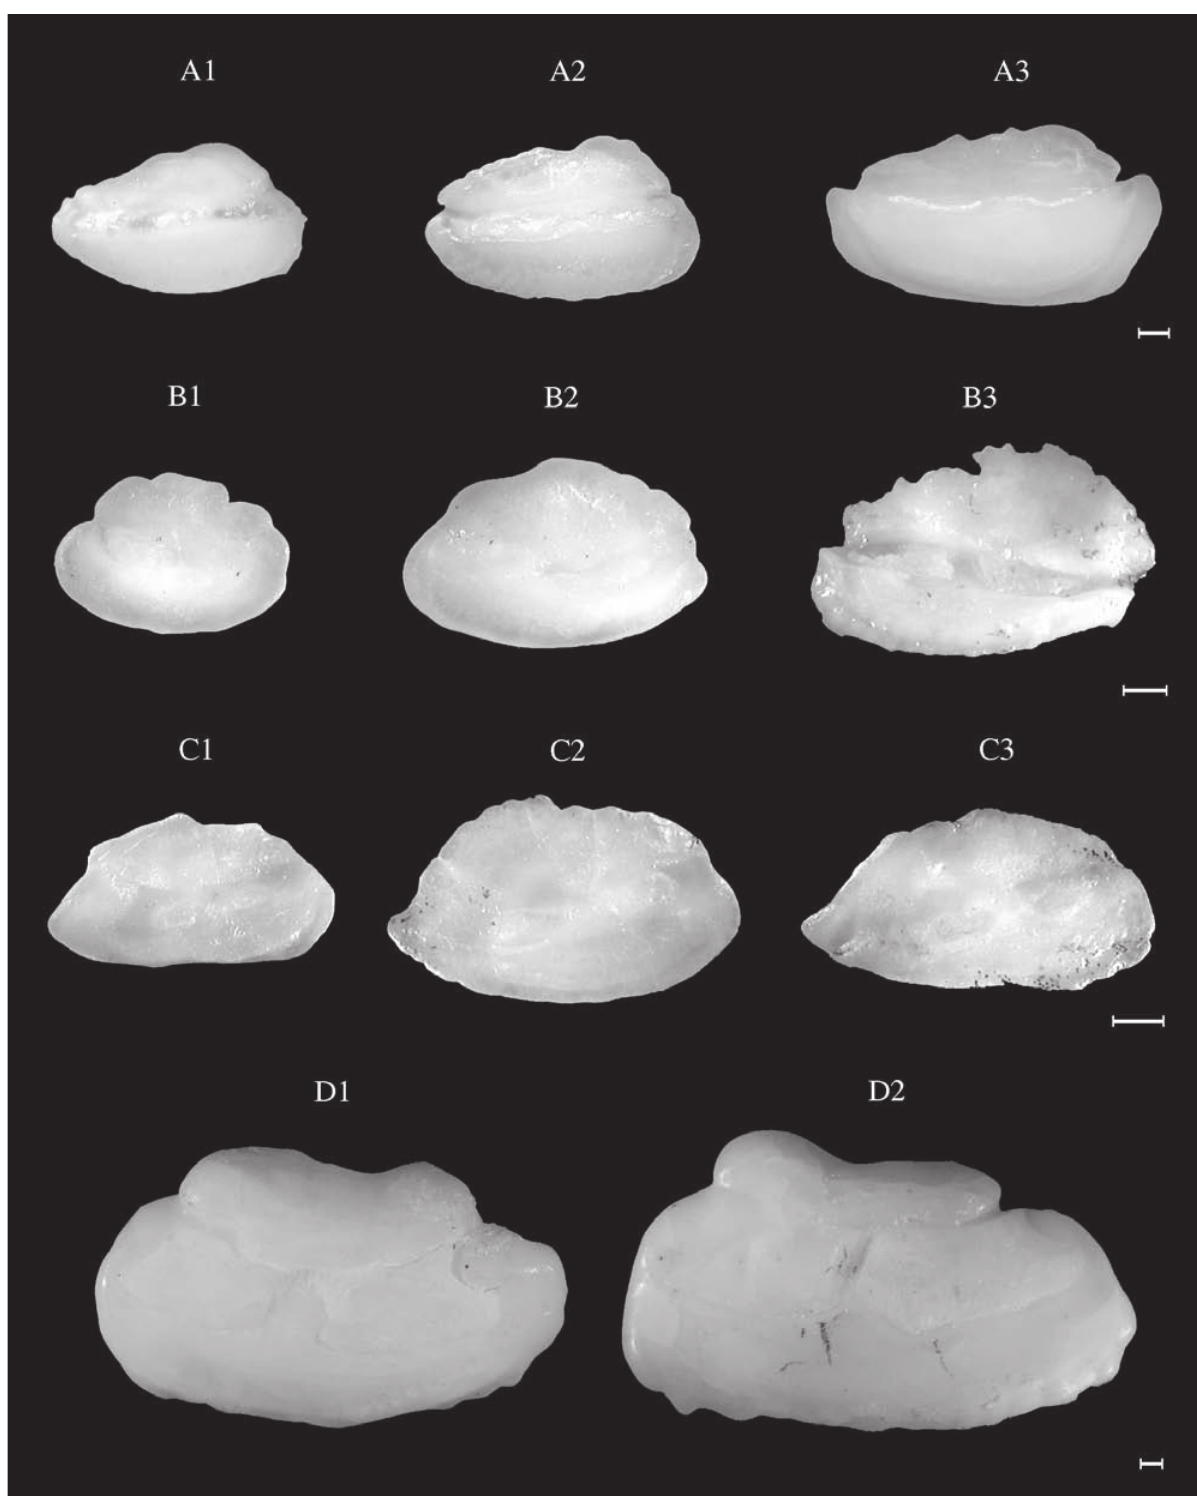
Fig. 25. – Caelorinchus mediterraneus (WM). PL: A1, 5.0 cm; A2, 6.5 cm; A3, 7.5 cm. Coryphaenoides guentheri (WM). PL: B1, 5.5 cm; B2, 7.0 cm; B3, 8.0 cm. Coryphaenoides mediterraneus (WM). PL: C1, 5.0 cm; C2, 6.0 cm; C3, 7.5 cm. Coryphaenoides rudis (CEA). CL: D1, 23.0; D2, 23.5 cm. Scale bar = 1